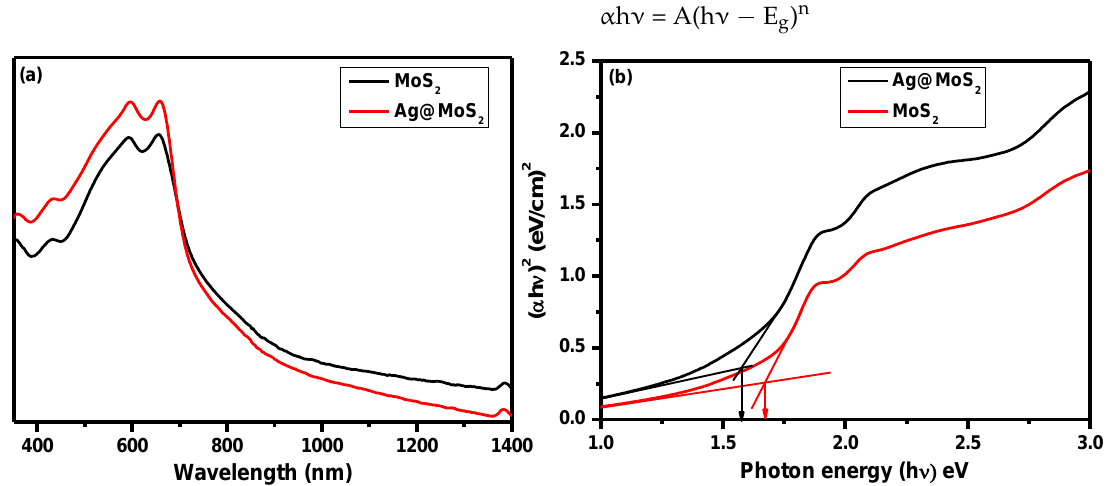
Figure 5. ( a ) Absorption spectra and ( b ) band gap plots for the MoS 2 and Ag-MoS 2 composites.